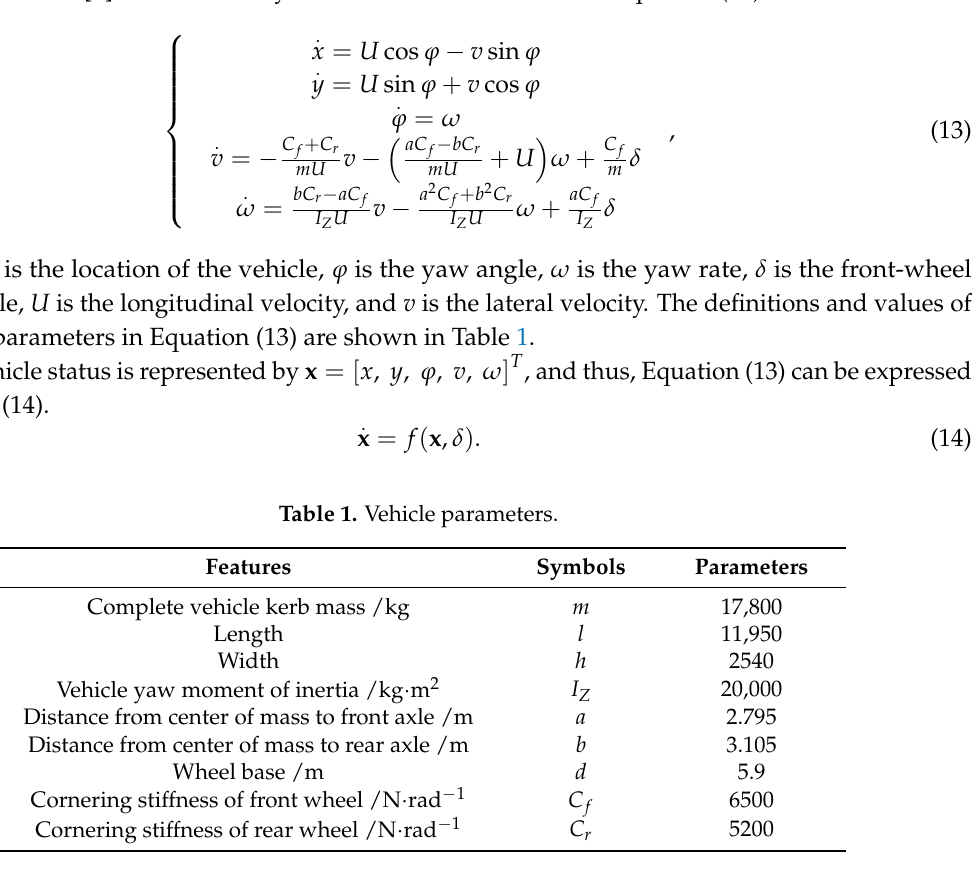
Table 1. Vehicle